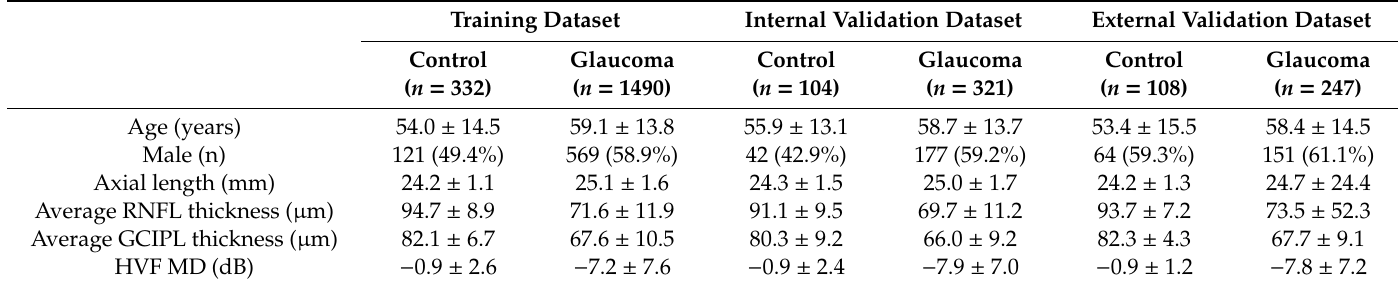
Table 1. Baseline characteristics of subjects included in the training, internal validation, and external validation datasets.